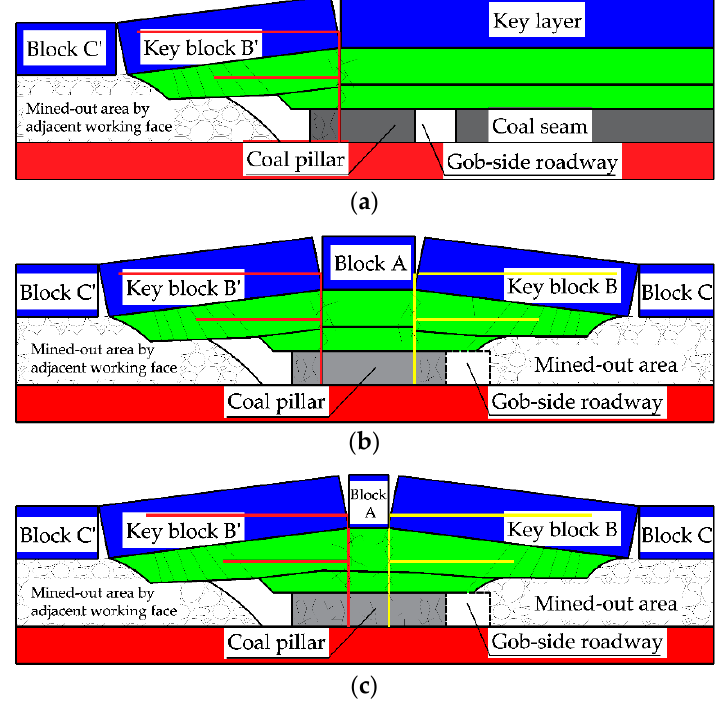
Figure 11. Layout of the overlying strata structure on the gob-side roadway.